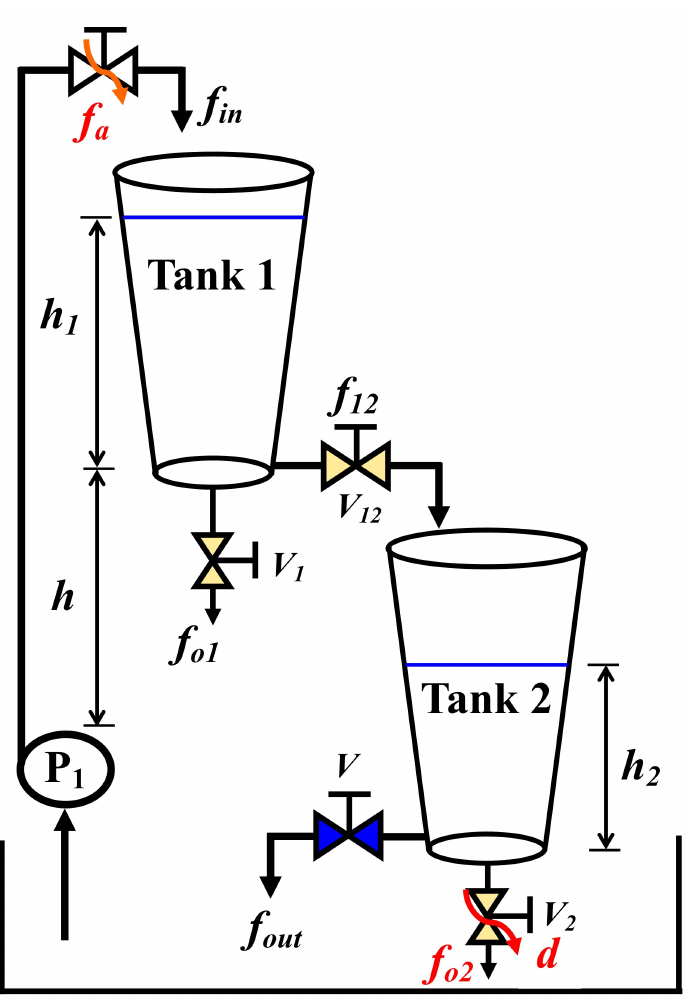
Figure 3. Prototype structure of frustum two-tank level control system